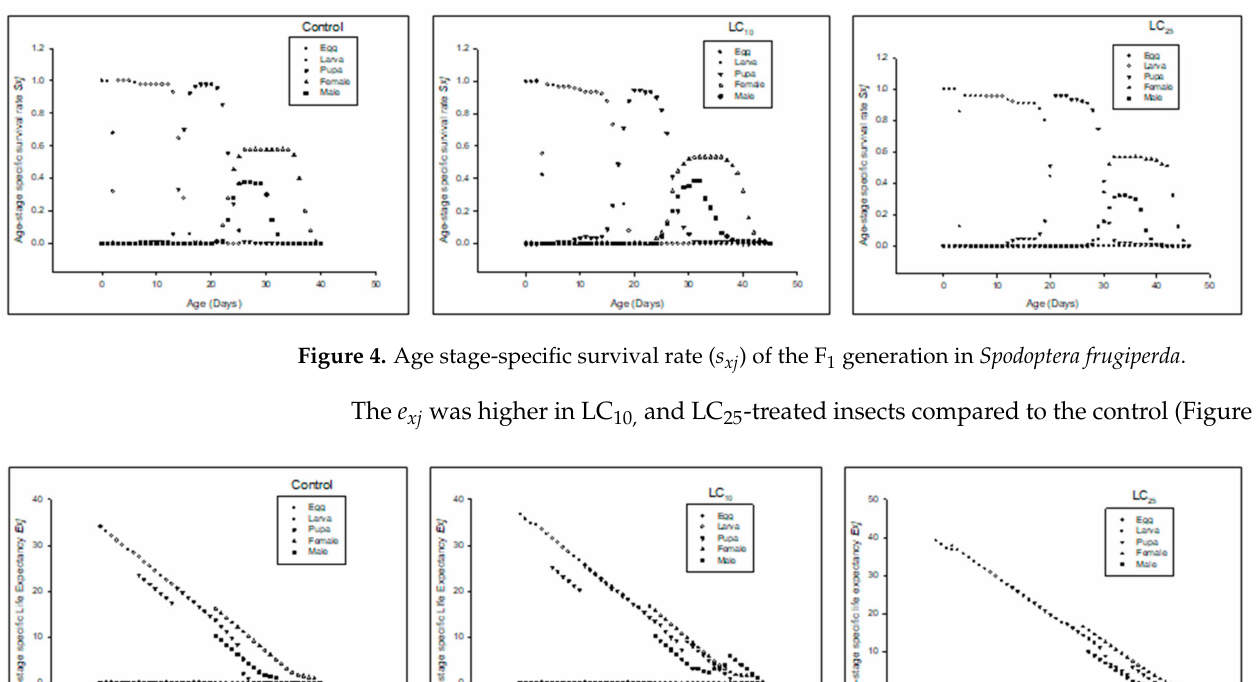
Figure 3. Age stage reproductive value ( v xj ) of the F 0 generation in Spodoptera frugiperda . The s xj of F 1 (first filial generation) denoted that the overall life span was prolonged in LC 10 and LC 25 compared to the control (Figure 4).